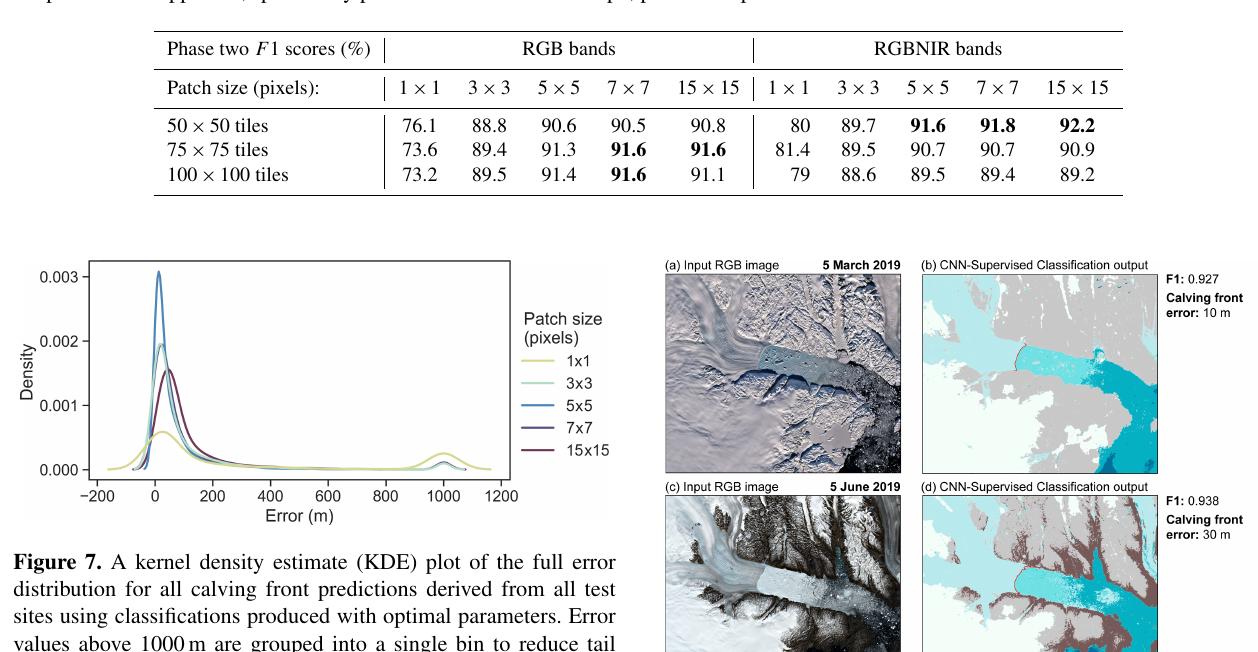
Table 1. F 1 scores for all test data combined (single training). The highest values are highlighted in bold. RGBNIR bands, 50 × 50 tiles, and the patch-based approach, specifically patches of 5 × 5 to 15 × 15px, produced optimum classification results.